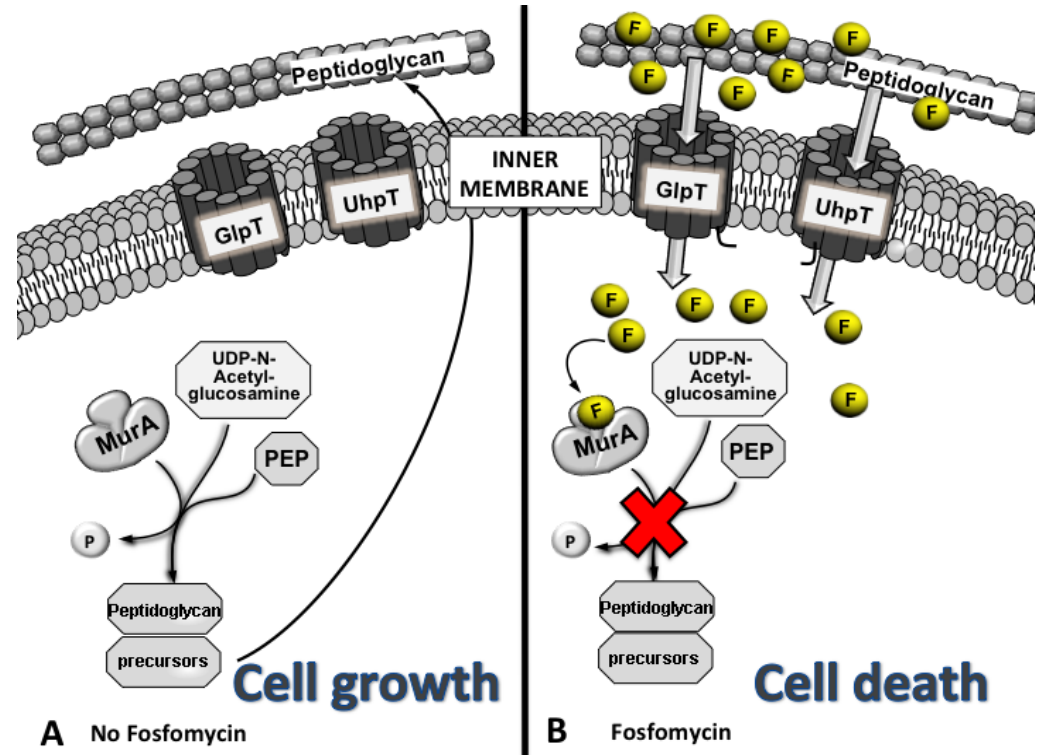
Figure 2. Although transporters are usually very selective, the chemical structure of fosfomycin mimics both glycerol-3-P (G3P) and glucose-6-P (G6P), which are transported under normal conditions. MurA catalyses the formation of UDP-GlcNac-3-O-enolpyruvate, a peptidoglycan precursor, from UDP-GlcNAc and PEP during the first step of peptidoglycan biosynthesis, allowing cell growth ( A ). In contrast, when fosfomycin (F) is present, it is transported inside the cell by GlpT and UhpT, blocking the UDP-GlcNac-3-O-enolpyruvate synthesis by mimicking the original substrate of MurA, PEP, avoiding cell wall synthesis and leading to cell death ( B ). For simplicity, only peptidoglycan and the inner membrane are